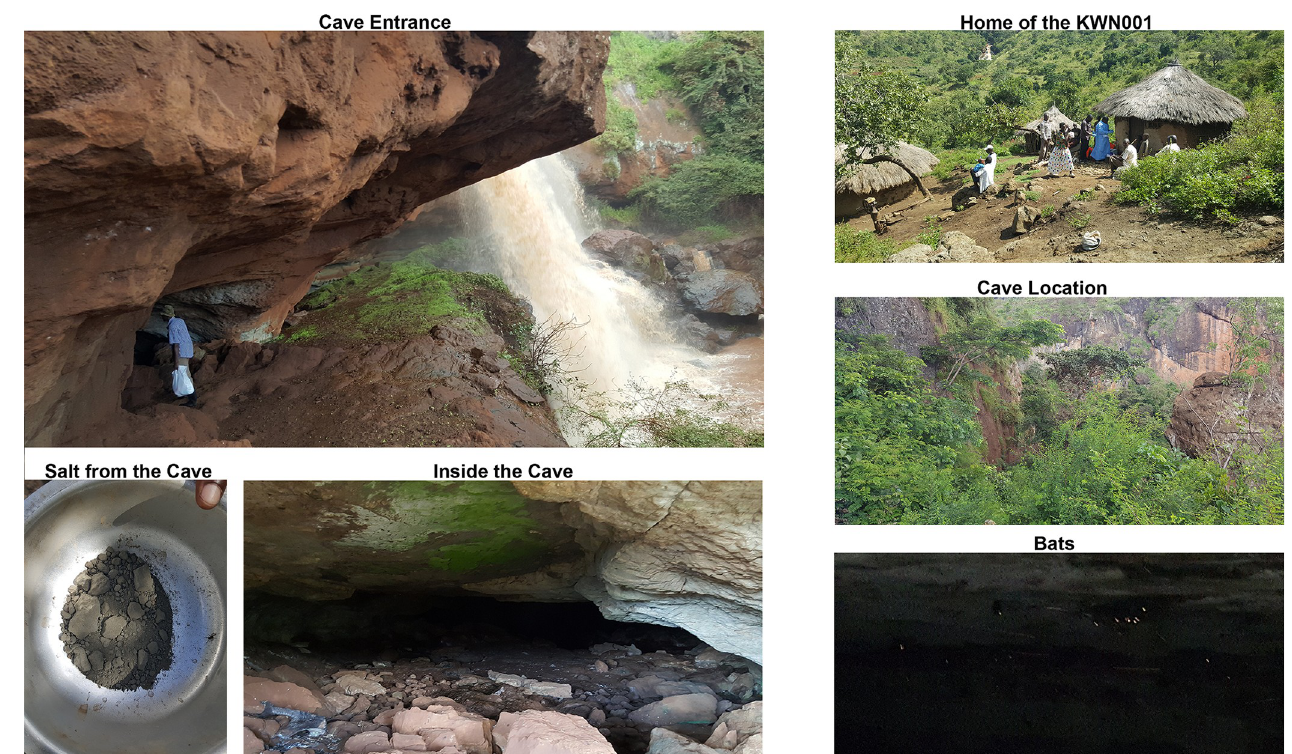
Fig 5. Kaptum cave and gopil falls on the sundet river in Kween District, home of the probable case, salt mined in the cave and bats of Rousettus species inside the cave (credit: luke nyakarahuka).